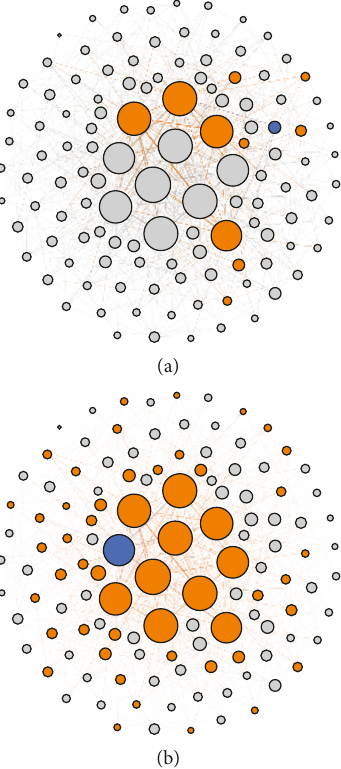
Figure 8: Neighborhood of a small bank (a) and a large bank (b) in the banking network of 120 banks. The small (large) bank is colored in blue, whereas its immediate neighbors are colored in orange. The remaining banks are colored in grey. The node size is weighted by its degree. The network is constructed using the default values of model parameters (Section 3.2).